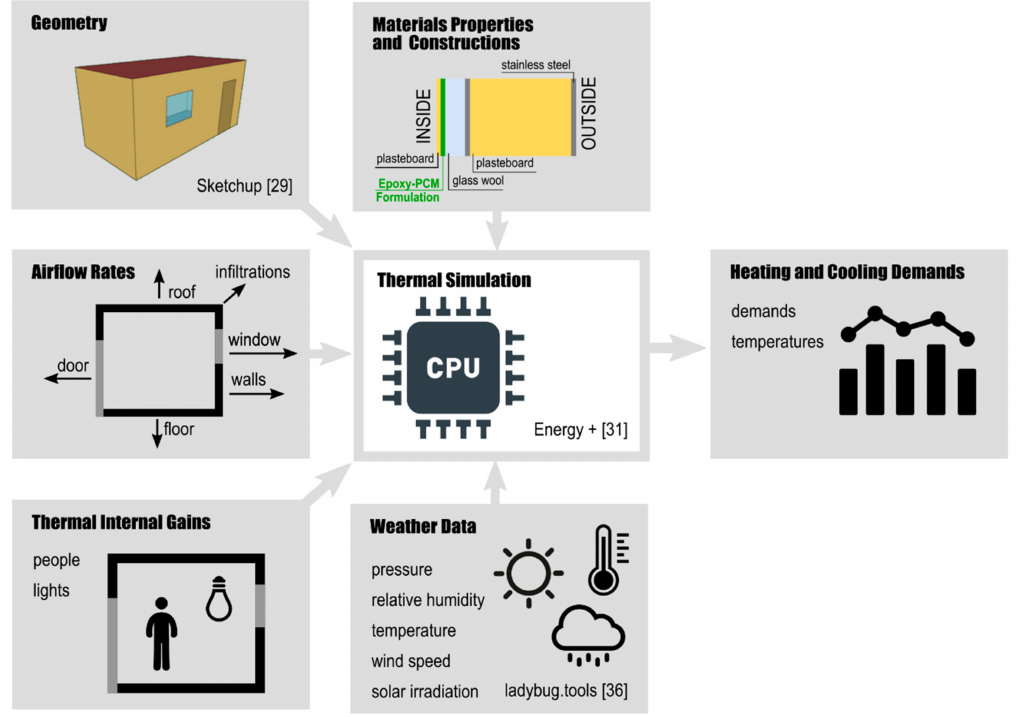
Figure 2. Modeling and simulation inputs and outputs